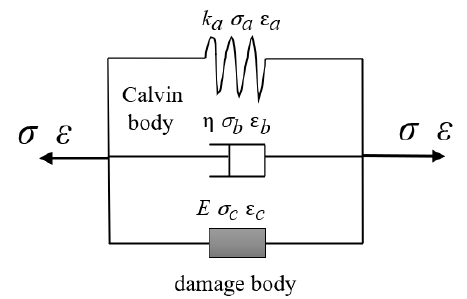
Figure 9. Damage intrinsic mechanics